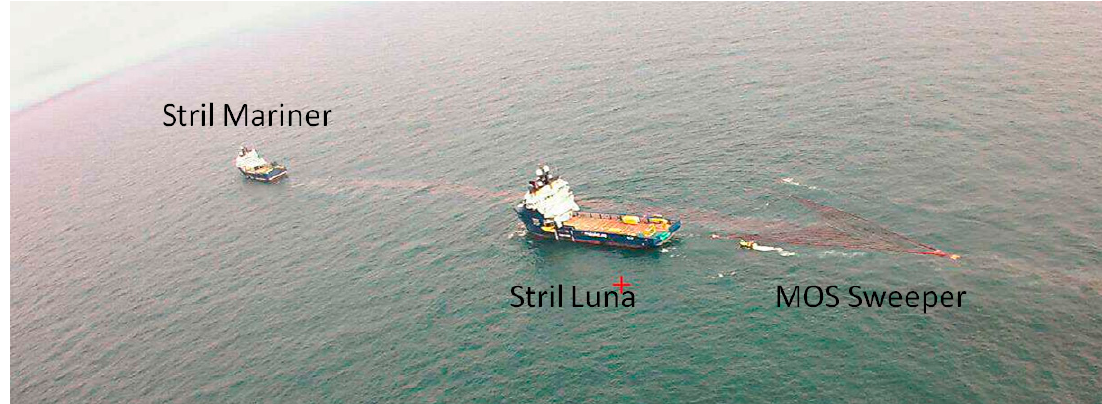
Figure 2. NOFO’2015 oil spill cleanup exercise: ( a ) MOS Sweeper and ( b ) DESMI Boom recovery systems tested on 9 June 2015 (photographs provided by NOFO).